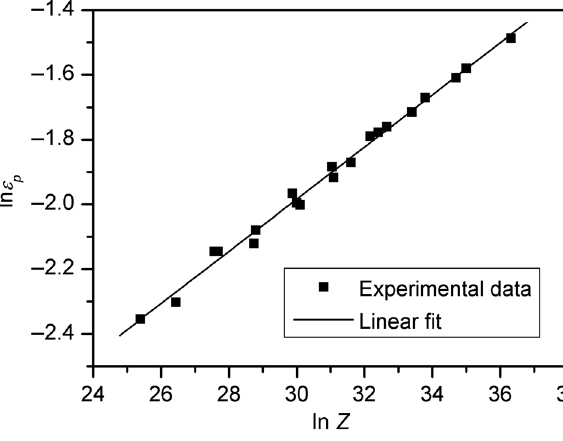
Figure 7: Relationship between ln ε p and ln Z